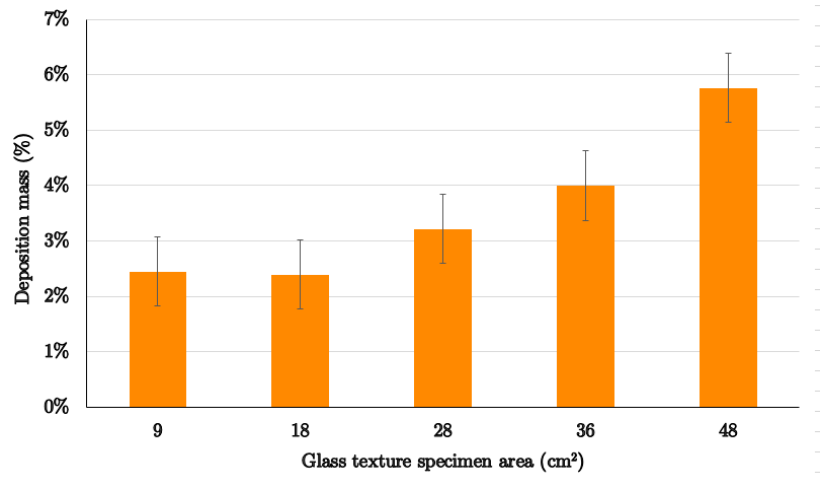
Figure 11. Effect of GT dimensions on CNTs deposition by EPD.